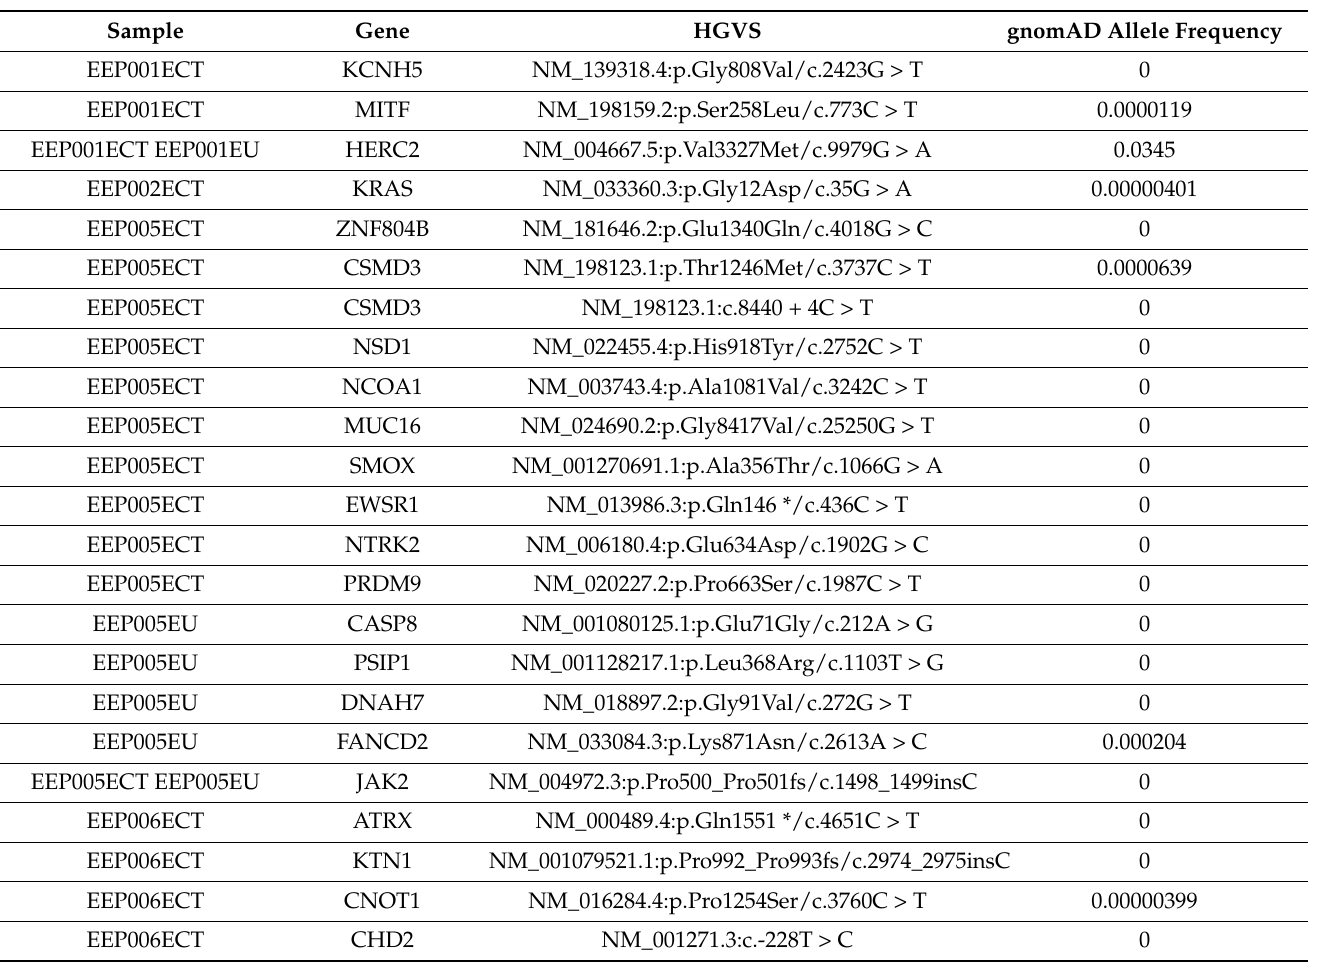
Table 1. Somatic non-silent variants were detected in the examined patients in an ectopic (ECT) or eutopic (EU) endometrial tissue. Localization and type of mutation were described in concordance to Human Genome Variation Society (HGVS) nomenclature (variants are described on protein and cDNA level, “*”—stop codon). The allele frequency from all populations in the Genome Aggregation Database (gnomAD) was